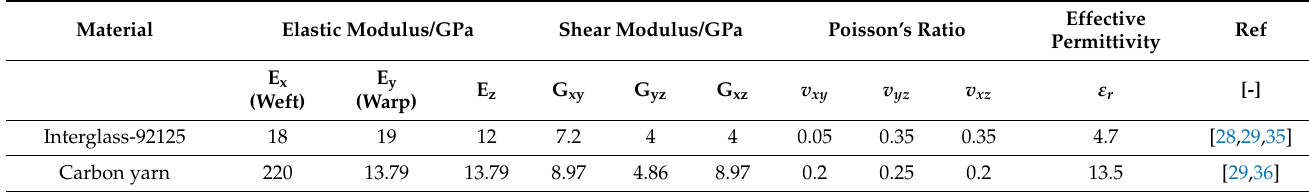
Table 6. Material properties of the unit cell